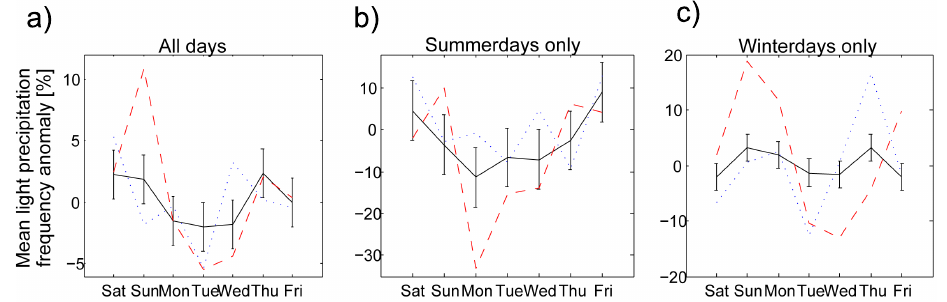
Fig. 9. Weekly cycle of regional mean (average of the 30 stations in the Black Triangle) light precipitation frequency anomaly, for the entire 1983–2008 period (solid black line), the more polluted 1983–1987 period (red dashed line) and the cleaner 2004–2008 period (blue dotted line) for (a) all days, (b) summer days and (c) winter days. Vertical bars show ± 1 standard deviation for the total period. polluted period (red dashed line), but the weekly cycles